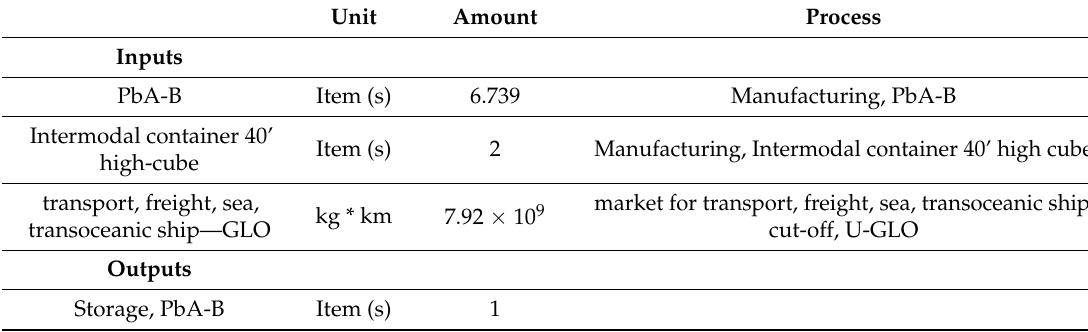
Table A19. Manufacturing Storage, PbA-B.